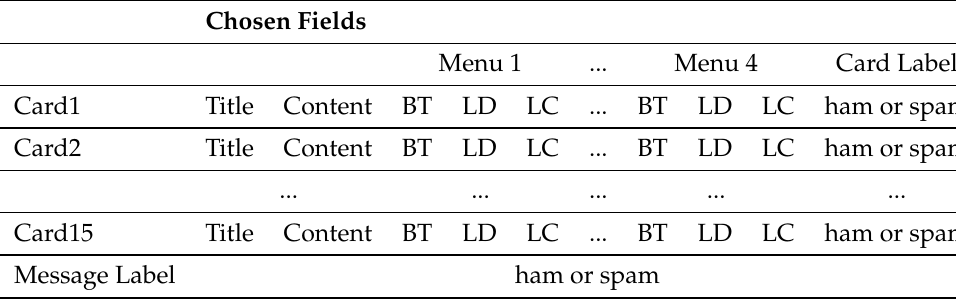
Table 1. 210 Fields chosen from 5G message specification a